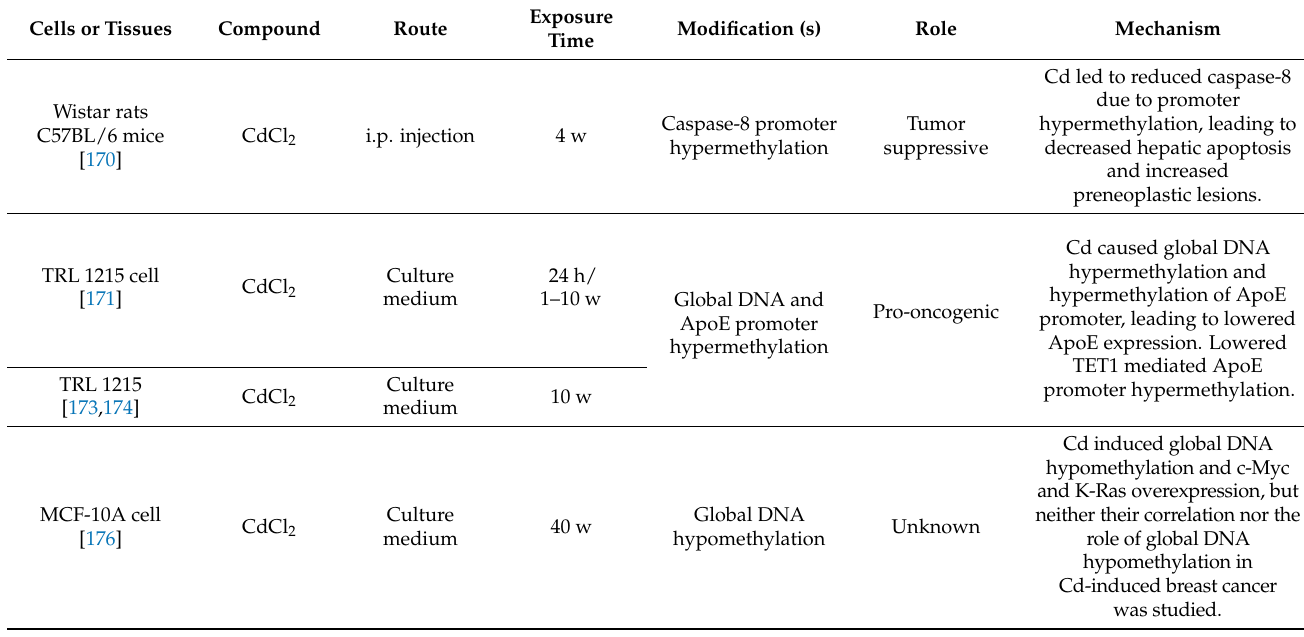
Table 7. Roles of altered DNA methylation in Cd-induced